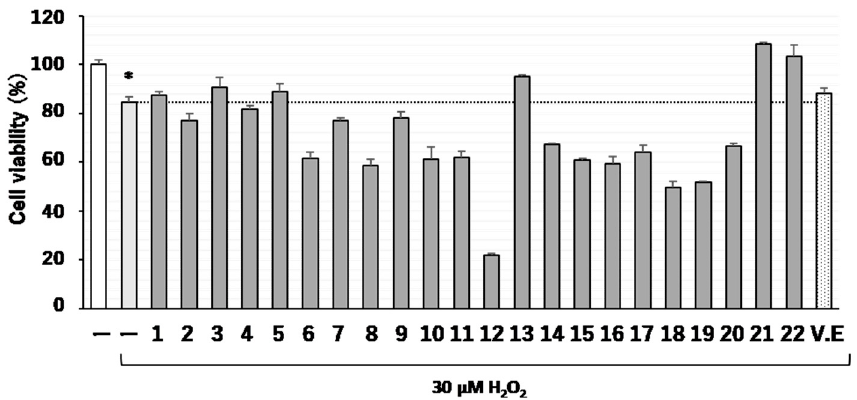
Figure 2. Effects of carbazole derivatives on neuro2a cell viability. Neuro2a cells pretreated with test compounds (compounds 1 – 22 at the concentration of 10 µ M or with vitamin E [V.E] at the concentration of 50 µ M) were exposed to 30 µ M H 2 O 2 . The results represent the mean ± SEM ( n = 5, different culture). Significance difference in values between the none-treated and H 2 O 2 -treated cells: * p < 0.05 (Student’s t test).